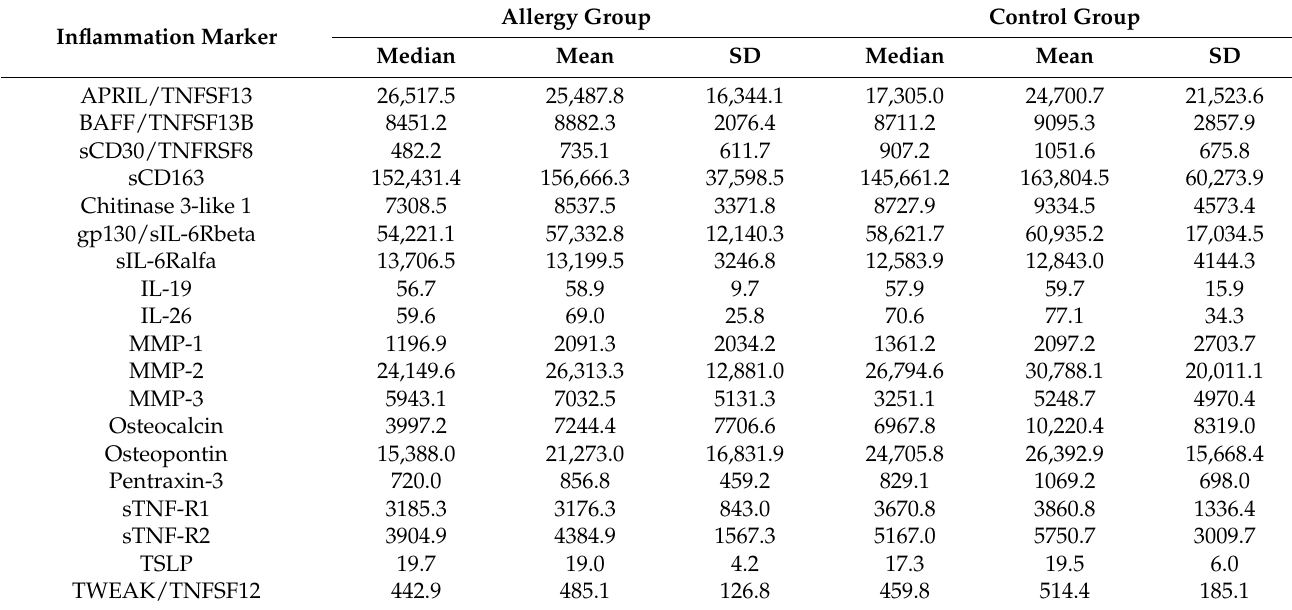
Table 2. The determined concentrations of 19 inflammation markers in control and studied groups. Concentration values are given in pg/mL.